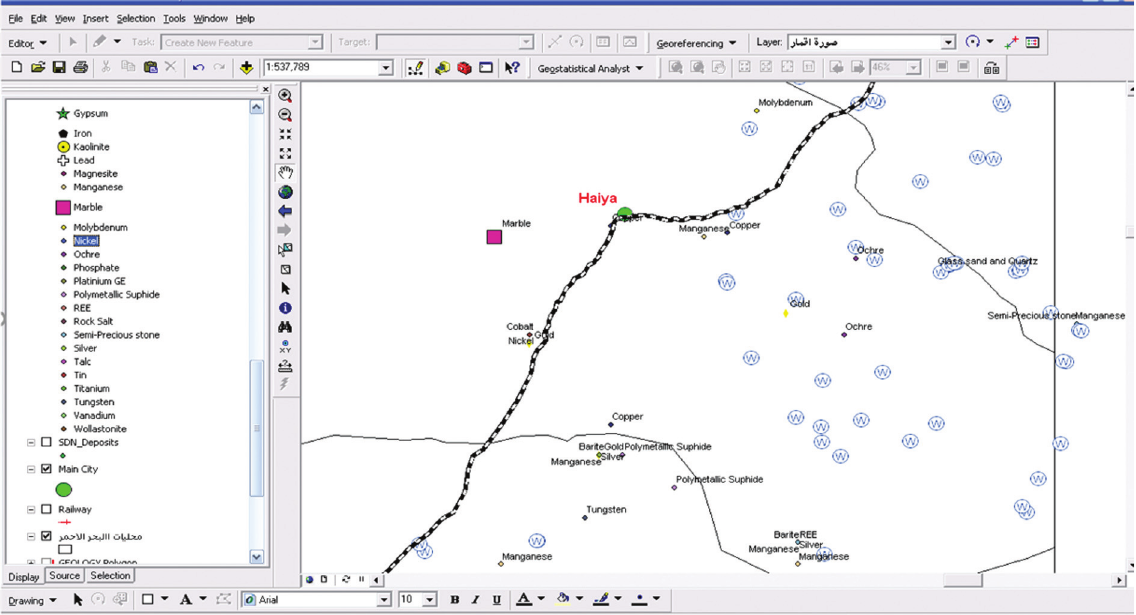
Figure 8: A map showing an ideal mining